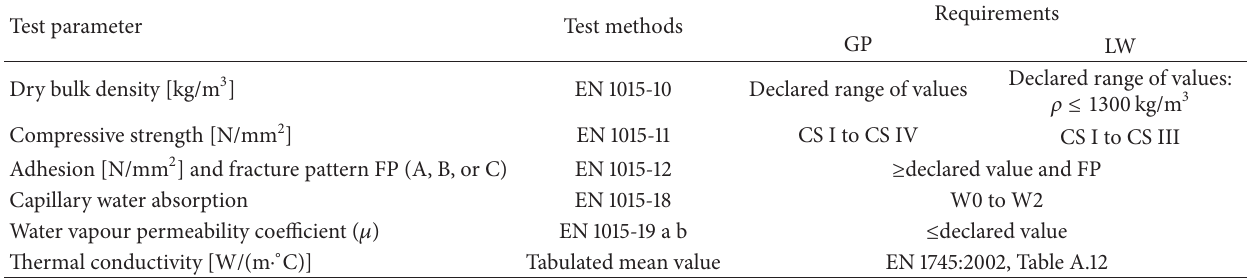
Table 1: Required tests for hardened mortars of general purpose (GP) and of lightweight